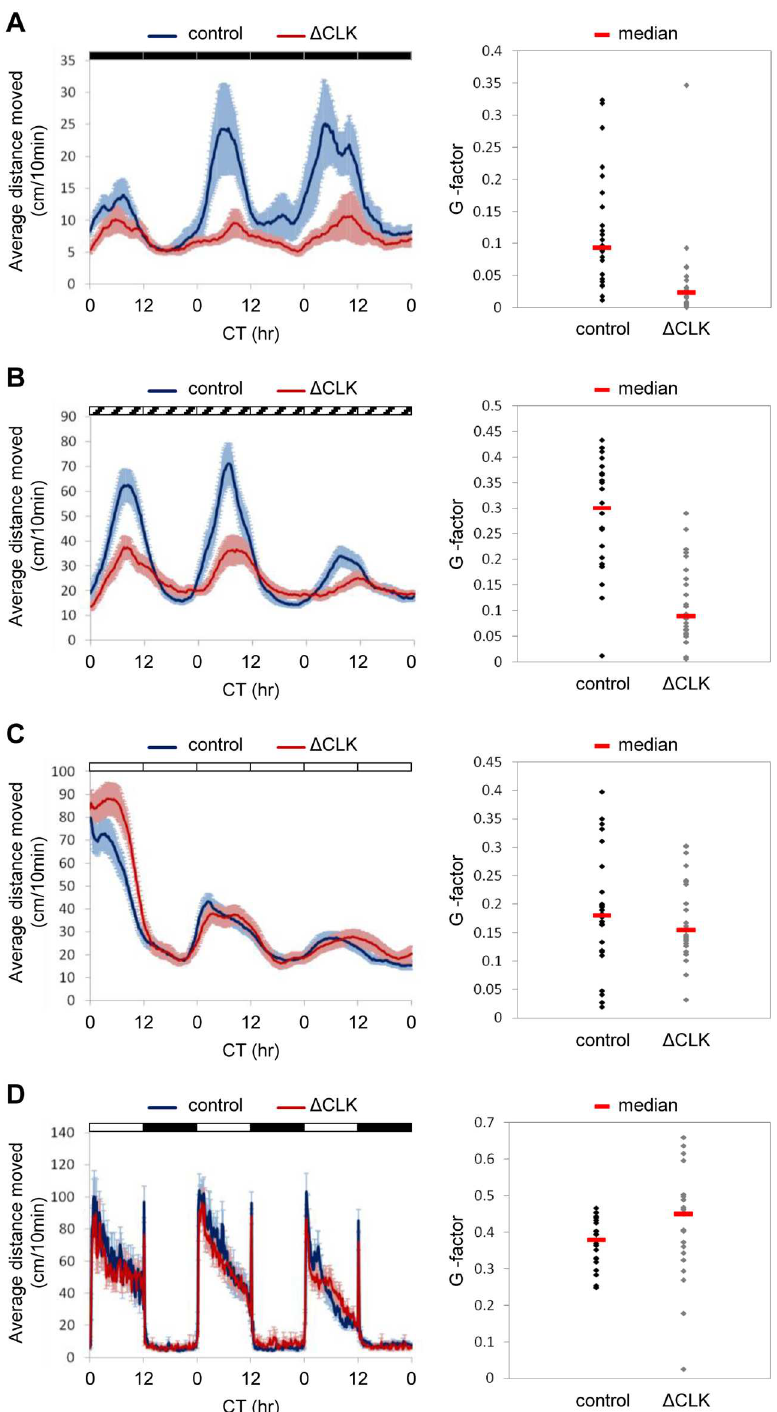
Fig 7. Circadian rhythms of locomotor activity under DD and DimDim, but not under LL or LD cycles, are affected by blocking the pineal clock. Analysis of locomotoractivity of 6–8 dpf Tg( aanat2 :EGFP- Δ CLK) larvae ( Δ CLK)and control larvae under variouslightingconditions. A–D, left chart: The averagedistance moved (cm/10 min) is plotted on the y-axis and circadiantime (CT) is plotted on the x-axis; error bars stand for SE ( n = 24); black, white and diagonallylined bars represent dark, light and dim light, respectively. A–D, right chart: Distributionof the G-factors (see ’Fourier analysis’in S1 Text) of Tg( aanat2 :EGFP- Δ CLK) and